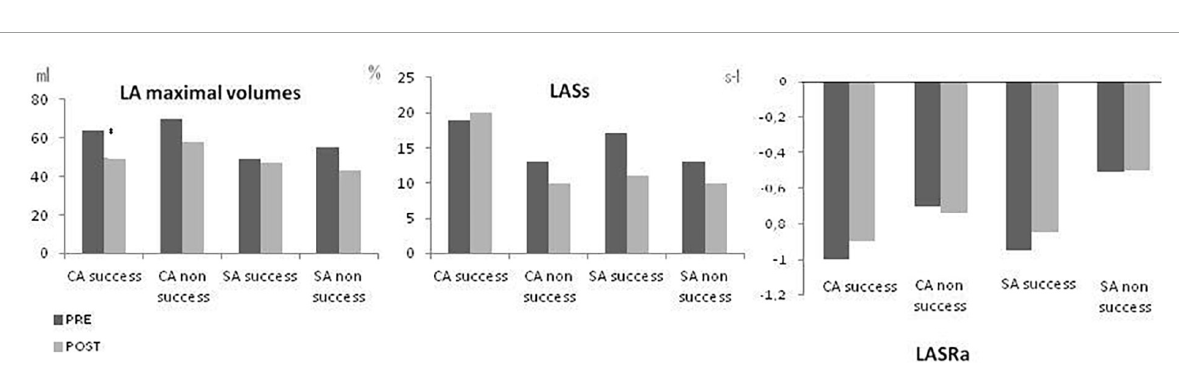
FIGURE3 Effect of catheter (CA) and surgical ablation (SA) on LA size (LA maximum volume), LA reservoir function (LASs l ) and LA booster function (LASRa l ) depending of the success of the procedure in eliminating AF. PRE: pre-ablation and POST: post-ablation. CA, Catheter ablation; SA, surgical ablation. * p < 0.05 PRE vs.